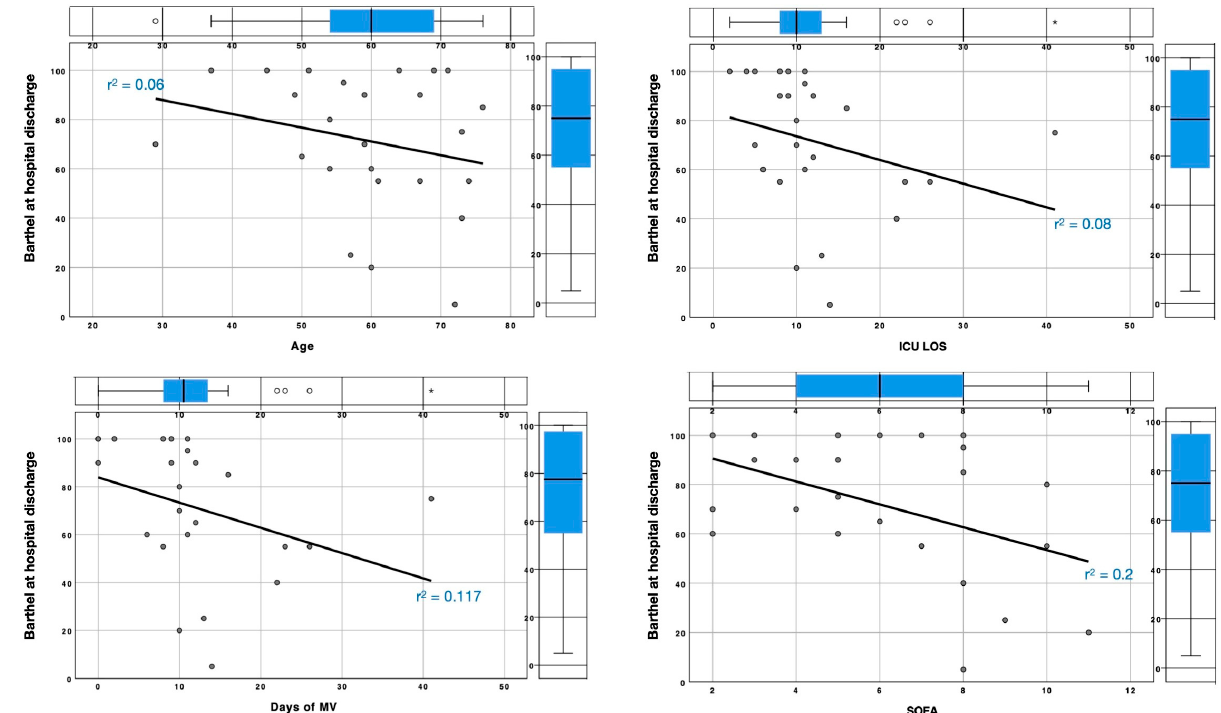
Figure 3. Linear regression of acute Barthel index. Linear regressions of Barthel index at hospital discharge compared to age, ICU LOS, days of MV and admitting SOFA score. ICU LOS = intensive care unit length of stay, MV = mechanical ventilation and SOFA = Sequential Organ Failure Assessment.